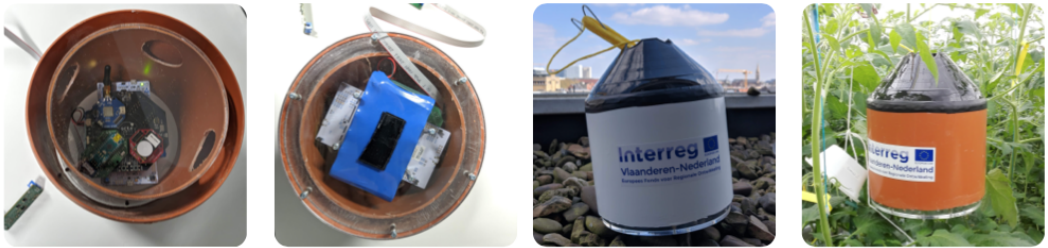
Figure 6. The airflow box.